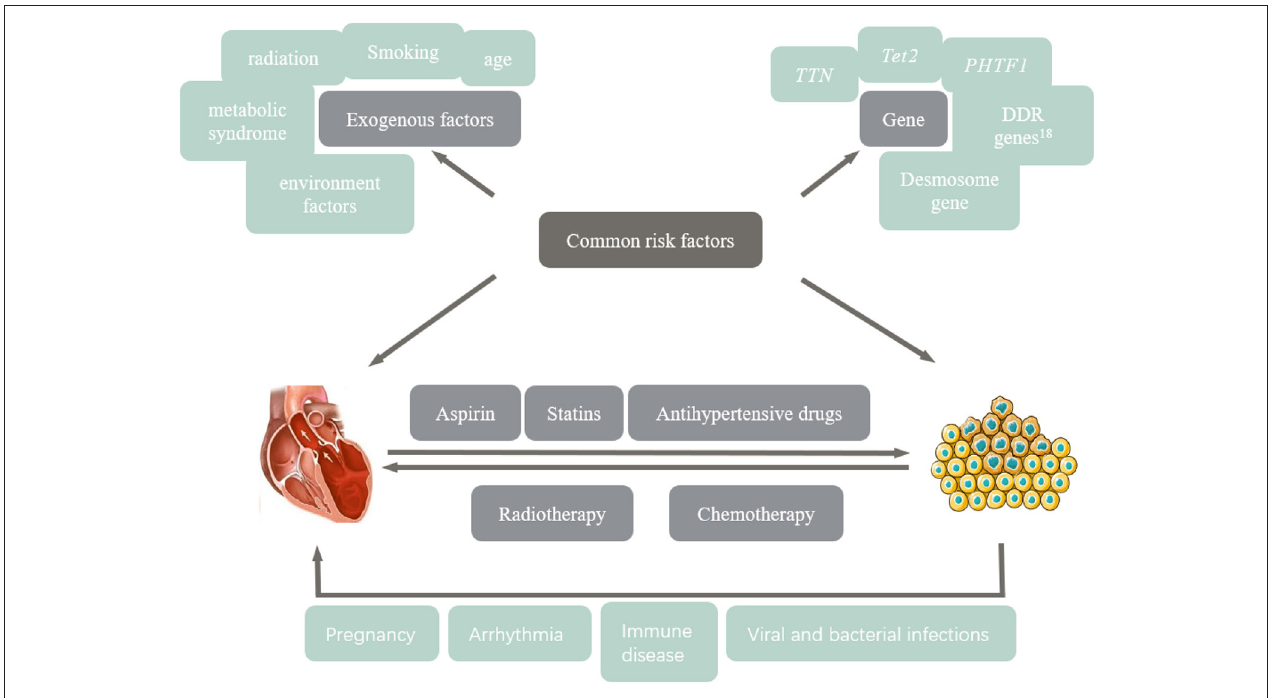
FIGURE 1 | The multiple blow theory is that anti-tumor therapy leads to cardiotoxicity.